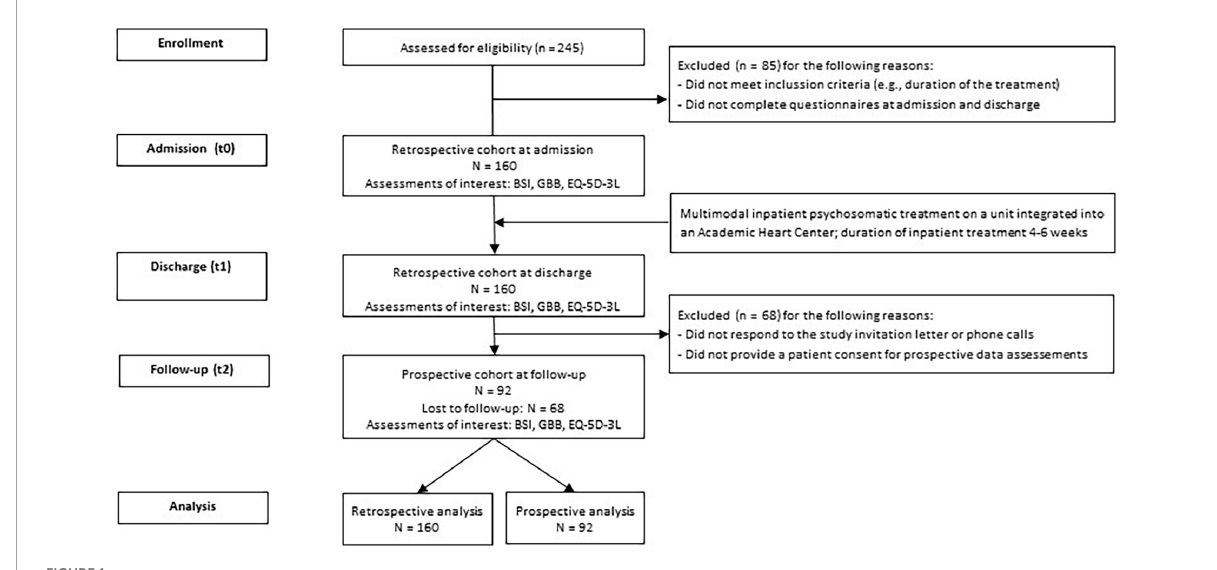
FIGURE1 Flow chart of the